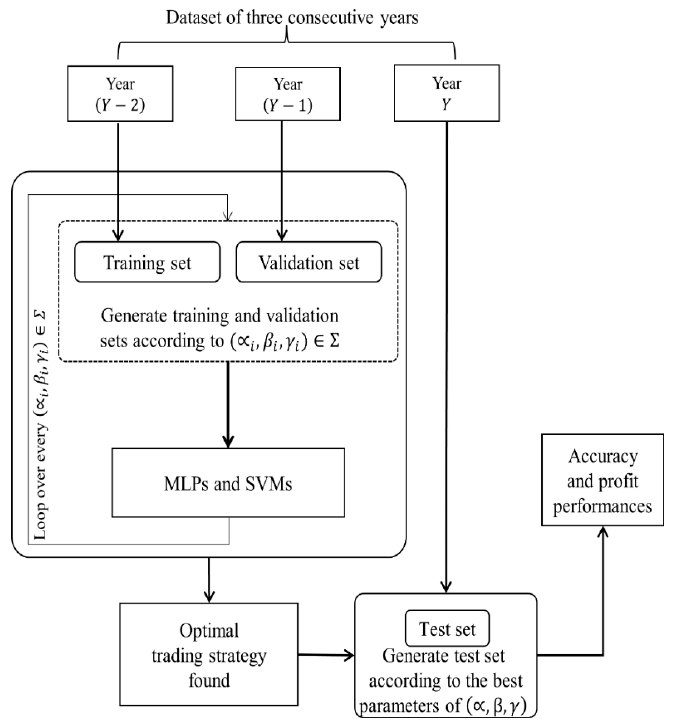
Figure 1. Overall framework of our method.